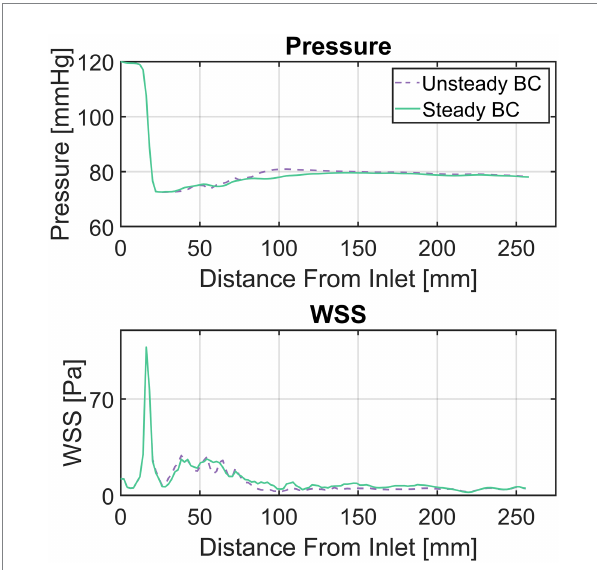
FIGURE 3 Comparison between a simulation with unsteady flow boundary conditions (BC) and a steady flow BC at peak systolic flow rate for a patient with a severe aortic stenosis. Top diagram compares pressure, bottom diagram wall-shear-stress (WSS). The flow curve for the ejection phase as well as the peak-systolic flow rate were derived from left-ventricular volumetry